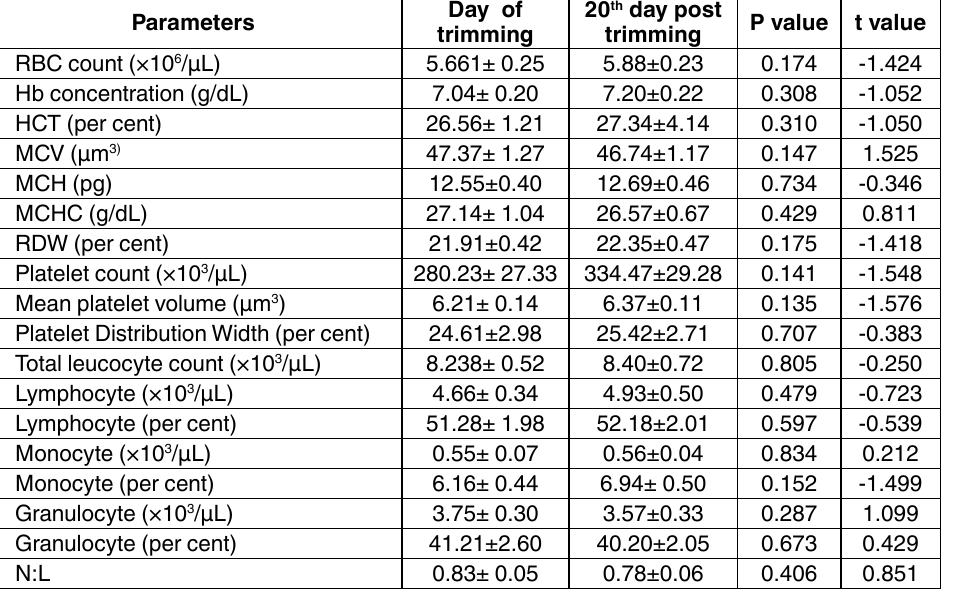
Table 1. Haematological parameters (mean ± SE) in lame cows on day one and day 20 of therapeutic hoof trimming